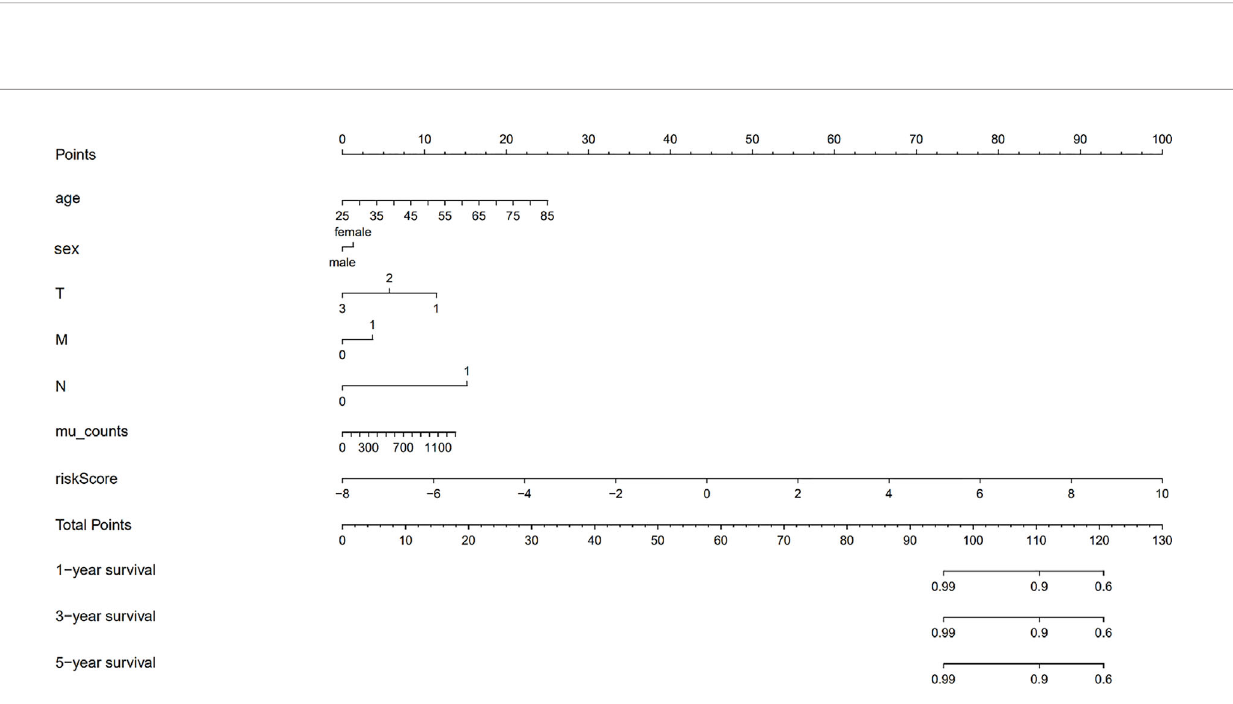
FIGURE 6 | The nomograph model predicting 1-, 3-, and 5-year survival in patients with cholangiocarcinoma based on age, sex, TMN stage, mutation counts, and risk